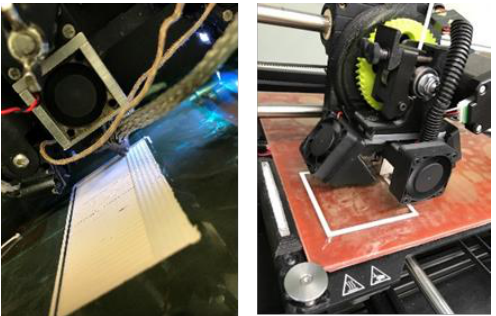
Figure 2. Printing of thin-sheet specimens by nScrypt 3Dn ( left ) and Lulzbot Taz 6 ( right ) printers for characterization.